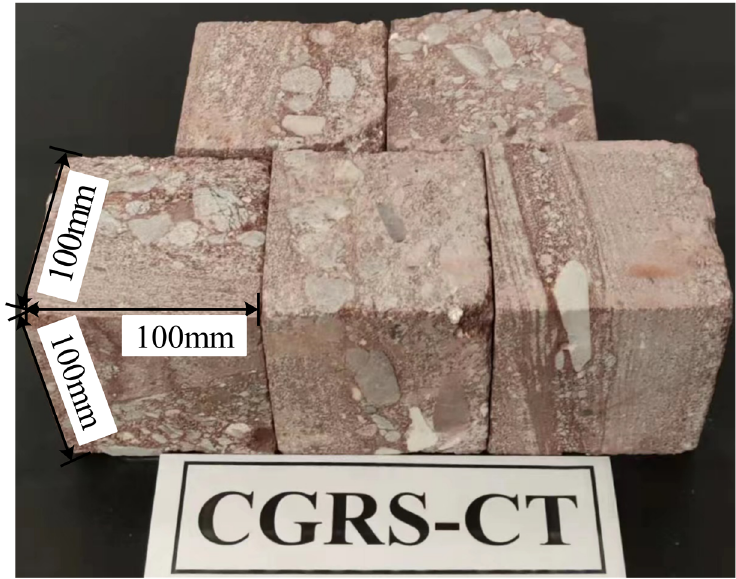
Figure 1. The sandstone blocks prepared for strength testing and CT scanning. “CGRS-CT” indicates: Coarse Grain Red Sandstone-CT. The length, width, and height of the specimens are all 100 mm. The type of specimen is a sedimentary rock, and the mineral grains within it vary in size, with good CT imaging results. To ensure the consistency of the experiment, the laminar direction and the loading direction are parallel.